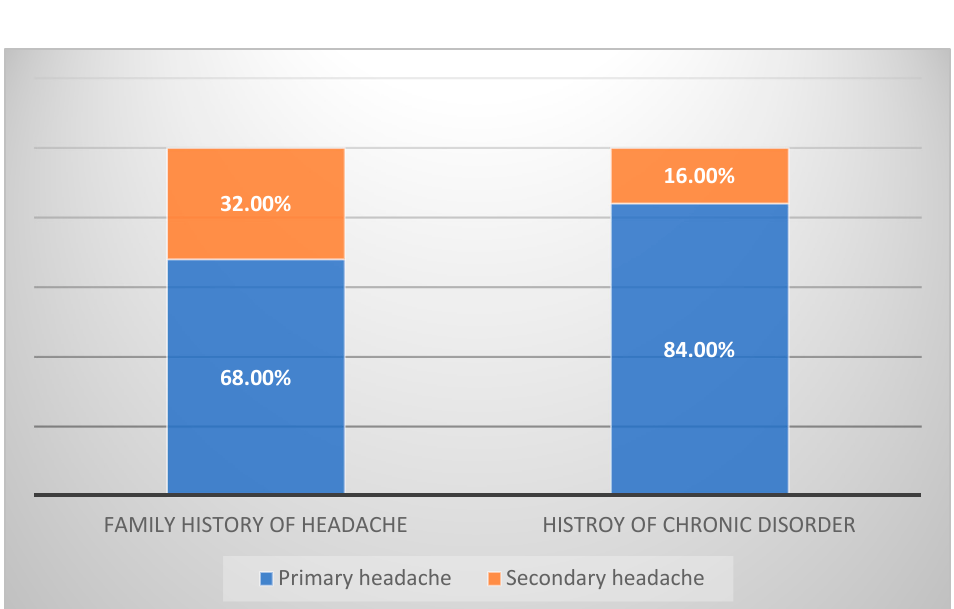
Figure 1. Type of headache with and without history.